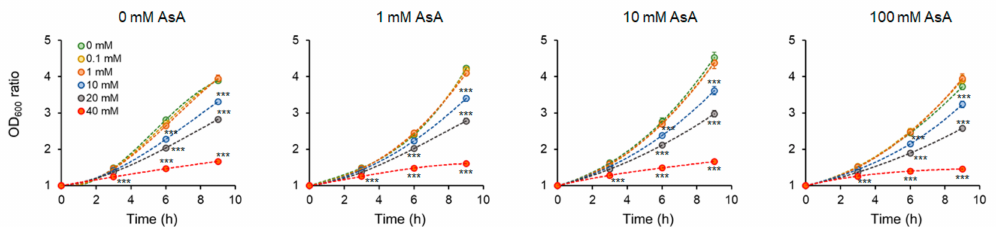
Figure 1. Determination of the cell growth intensity upon AA addition with and w/o AsA pre- treatment. Evaluated was the OD 600 ratio determined every three hours of incubation (3 h, 6 h, and 9 h) and calculated as the difference to the time point 0 h. Cells un- and pre-treated with AsA were subjected to indicated AA concentrations (0 mM green, 0.1 mM yellow, 1 mM orange, 10 mM blue, 20 mM grey, and 40 mM red). Increasing AA concentration led to a marked reduction of the cell growth ability. AsA treatment improved growth ability at 1 mM and 10 mM concentration, while 100 mM did not improve or even reduce the growth of cells. Each point represents the mean value ± SD of 4 individual samples. Statistical differences are indicated as p < 0.001 ***.